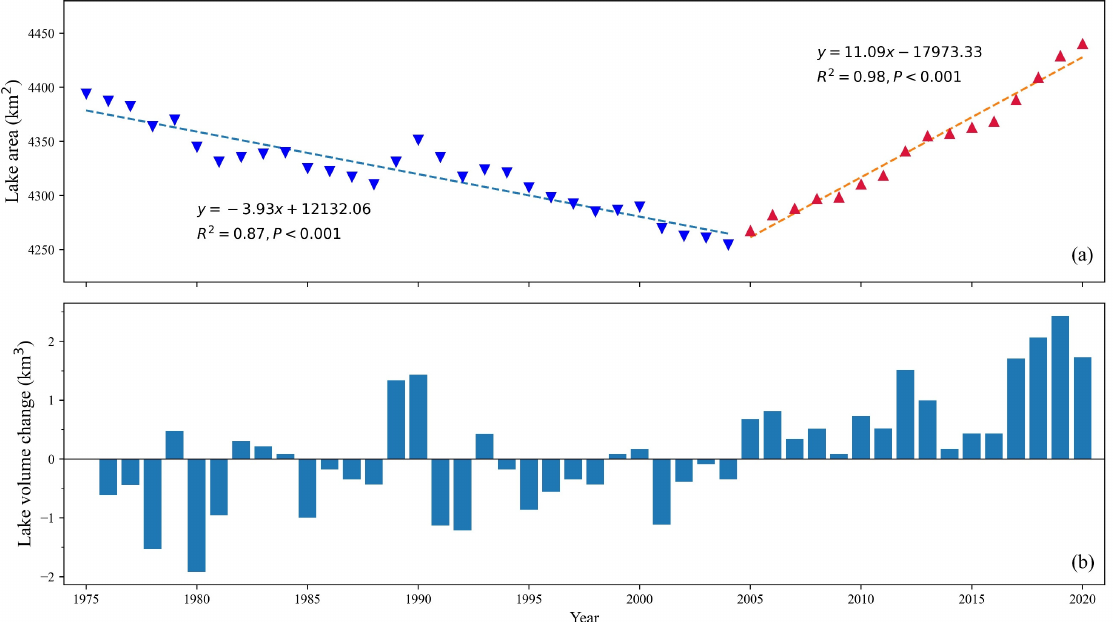
Figure 4. Change in ( a ) annual mean lake area and ( b ) annual mean lake water volume. The blue inverted triangles correspond to the lake area for the decreasing period, the red positive triangles represent the increase period, shaded area represents the 95% confidence interval. The blue bars represent lake water volume change from previous